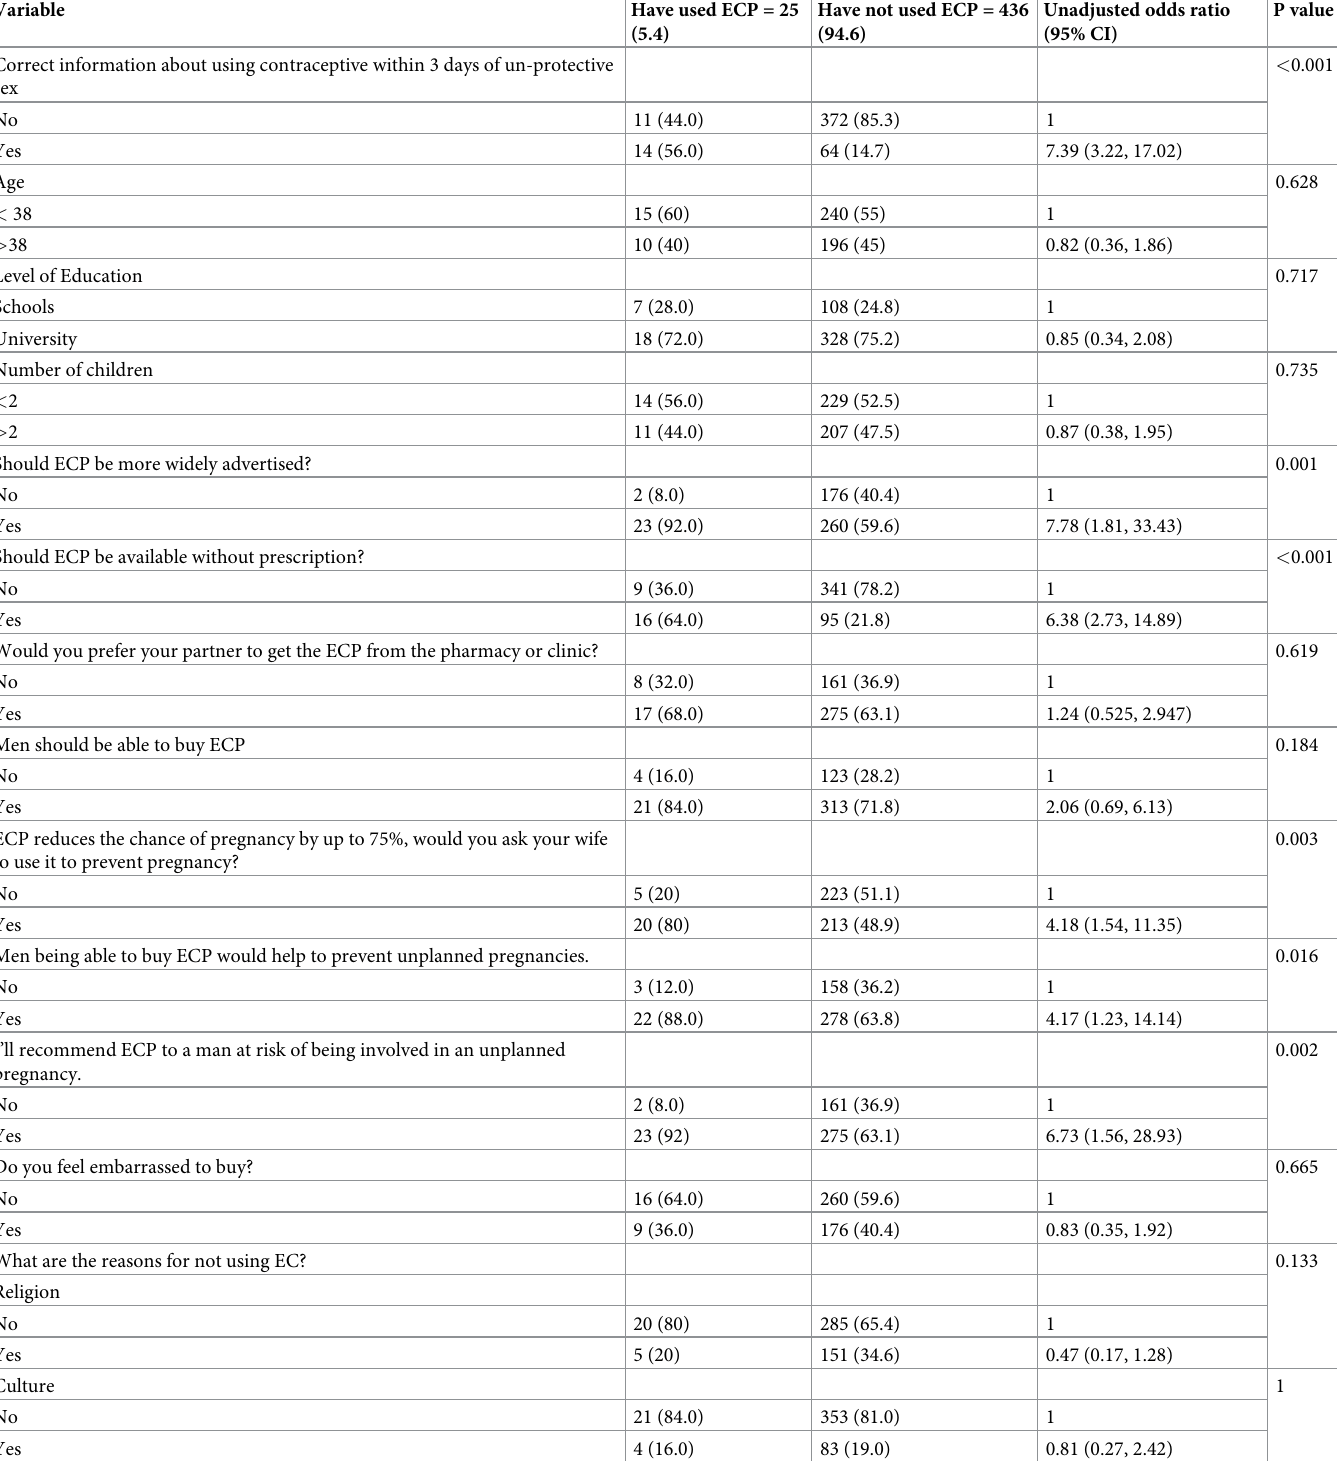
Table 6. Univariate analysis for the factors of ECP use among men.